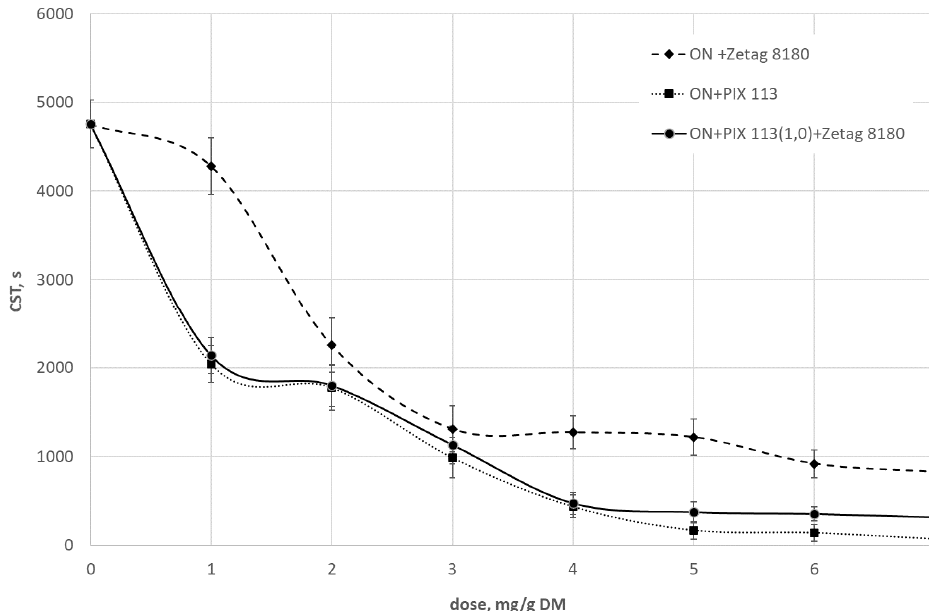
Figure 1. Effect of the dose of selected chemicals on CST of sonicated sludge (A 1 = 15.25 µm).